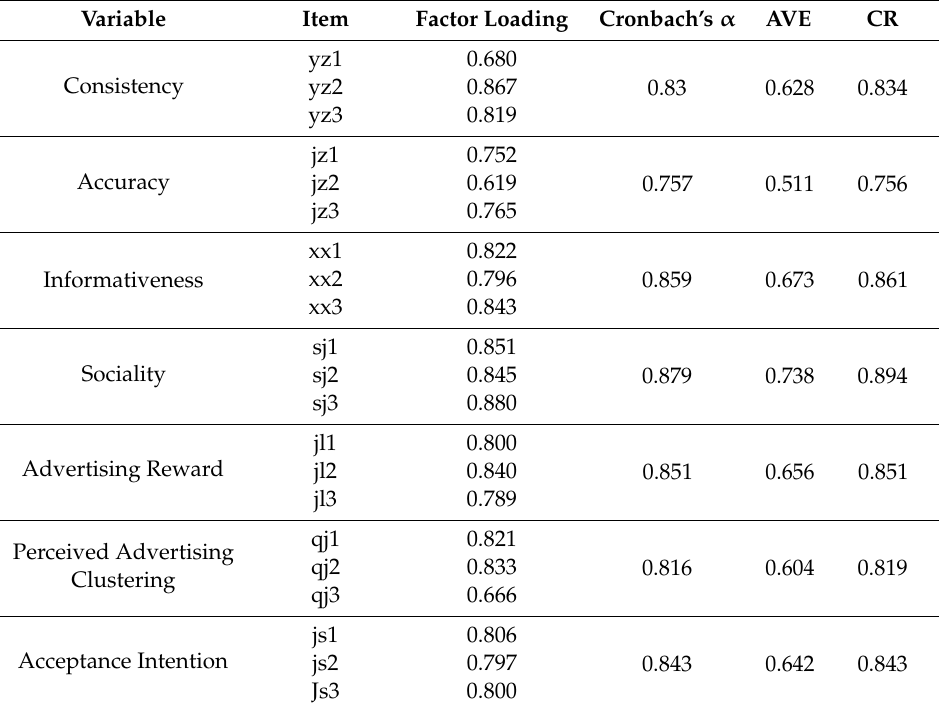
Table 2. Reliability and convergence validity test.